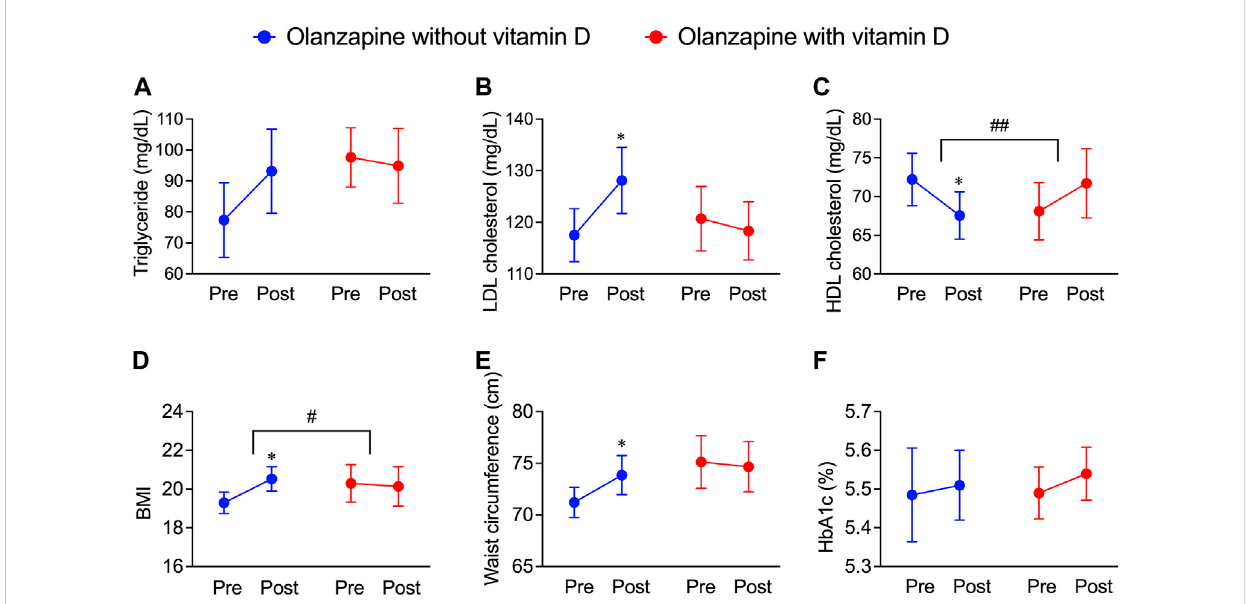
FIGURE 2 Deteriorativeeffectsofolanzapineonbloodlipidpro fi lesandbodyweightmaintenanceandtherescuingeffectsofvitaminDco-treatmentfromthe JMDC insurance claims. The data of pre-prescription and post-prescription periods were collected from the nearest test data before or after the olanzapine prescription within 1 year. Background characteristics were matched between groups ( n = 20) as shown in Table 2. (A – C) The annual blood test results from patients included in JMDC were extracted. (A) Serum concentrations of triglycerides, (B) low-density lipoprotein (LDL) cholesterol, and (C) high-density lipoprotein (HDL) cholesterol were expressed in units of mg/dL. (D,E) The annual body weights, heights, and waist circumferences includedintheJMDCwereextracted. (D) Bodymassindex(BMI)iscalculatedfrombodyweightsandheightsand (E) waistcircumferenceswereobtained bydirectmeasurement. (F) thelevel ofHbA1c expressed inunits ofpercentage ofblood. Dataareshown asmeans±SEM.* p < 0.05;apaired t